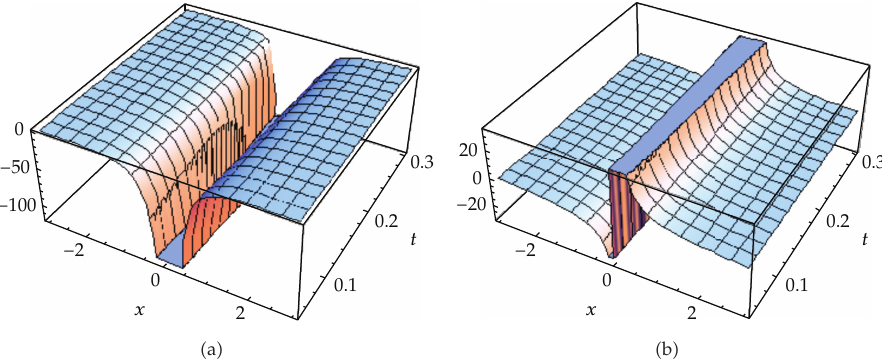
Figure 2: (cid:2) a (cid:3) The obtained u HAM for system (cid:2) 1.1 (cid:3) using 10-term approximation. (cid:2) b (cid:3) The obtained v HAM for system (cid:2) 1.1 (cid:3) using 10-term approximation. h (cid:8) − 1 .